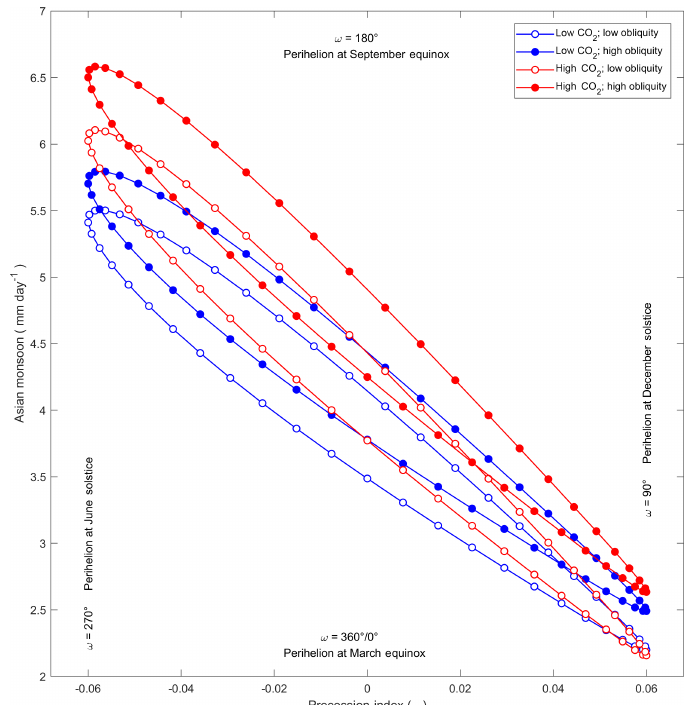
Figure 12. Emulated values of the Asian monsoon index, for the full range of the precession index ( e sin ω ), at low and high values of CO 2 and obliquity ( ε